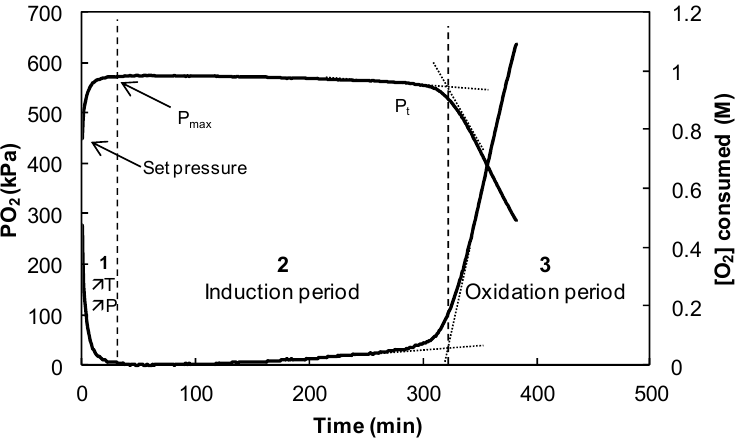
Figure 6. Evolution of the oxygen pressure ( left axis) and concentration of oxygen consumed ( right axis) during the oxidation of fatty acid methyl esters (FAMEs) in the presence of rosmarinic acid (5 × 10 − 4 mol·L − 1 ) at 90 °C